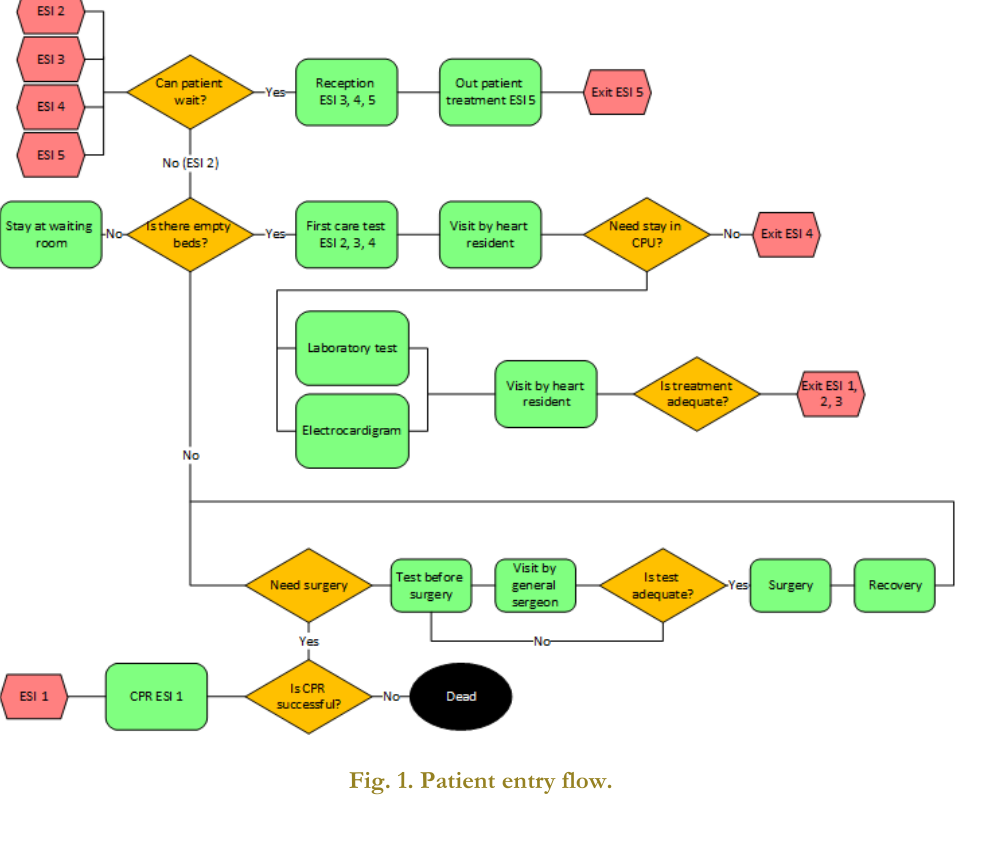
Fig. 1. Patient entry